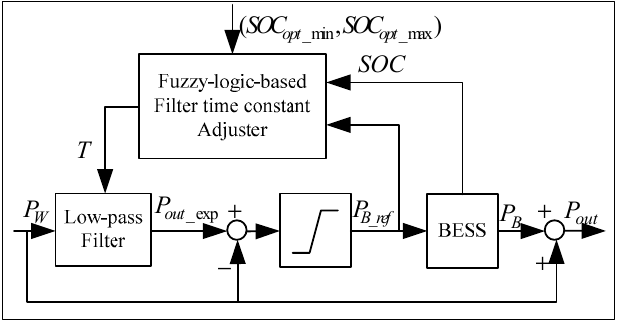
Figure 13. State of charge (SOC) real-time control module.